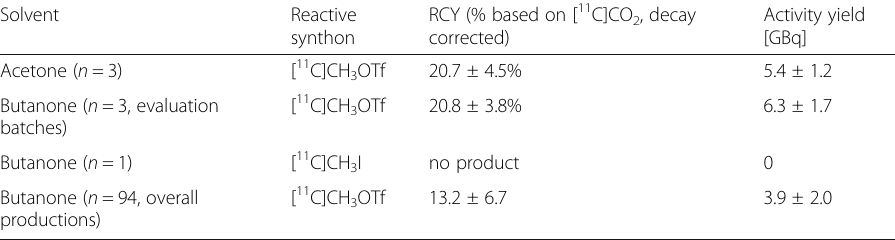
Table 1 Overview on evaluation batches and overall yield of [ 11 C]metoclopramide productions with changing reaction conditions